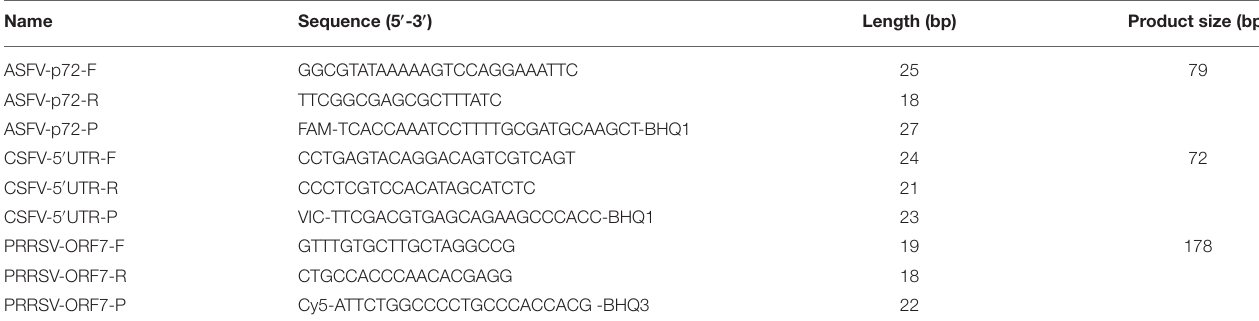
TABLE 1 | The primers and probes for detection of ASFV, CSFV, and